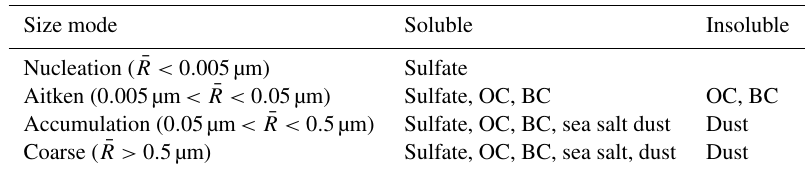
Table 1. Aerosol size modes and species in the M7 aerosol microphysics in HAM. Mode boundaries for the number median particle radii ¯ R are given for each mode.